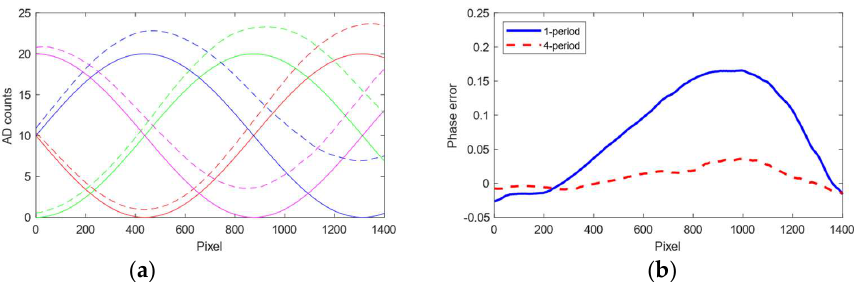
Figure 9. Effect of backscatter on phase estimates. ( a ) An ideal 1-period sinusoid is shown in solid, while the resulting curve when the backscatter profile from high turbidity is added to the signal is shown with the stapled curve. ( b ) The phase error caused by backscatter in high turbidities. We have included the phase error for the 1-period pattern and the 4-period pattern. The error is more prominent for the low period